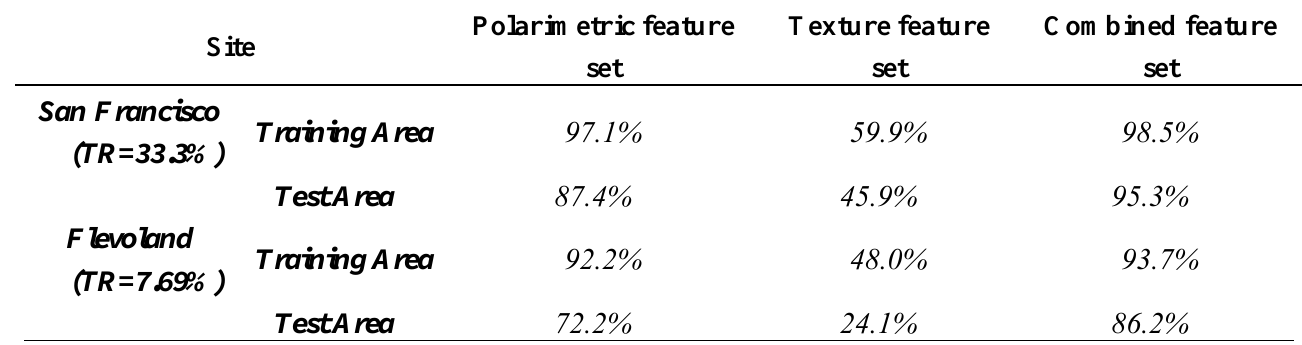
Table 7. Comparison of PNNs using polarimetric feature set, texture feature set, and combined feature set (TR denotes Classification Accuracy of Total Random).